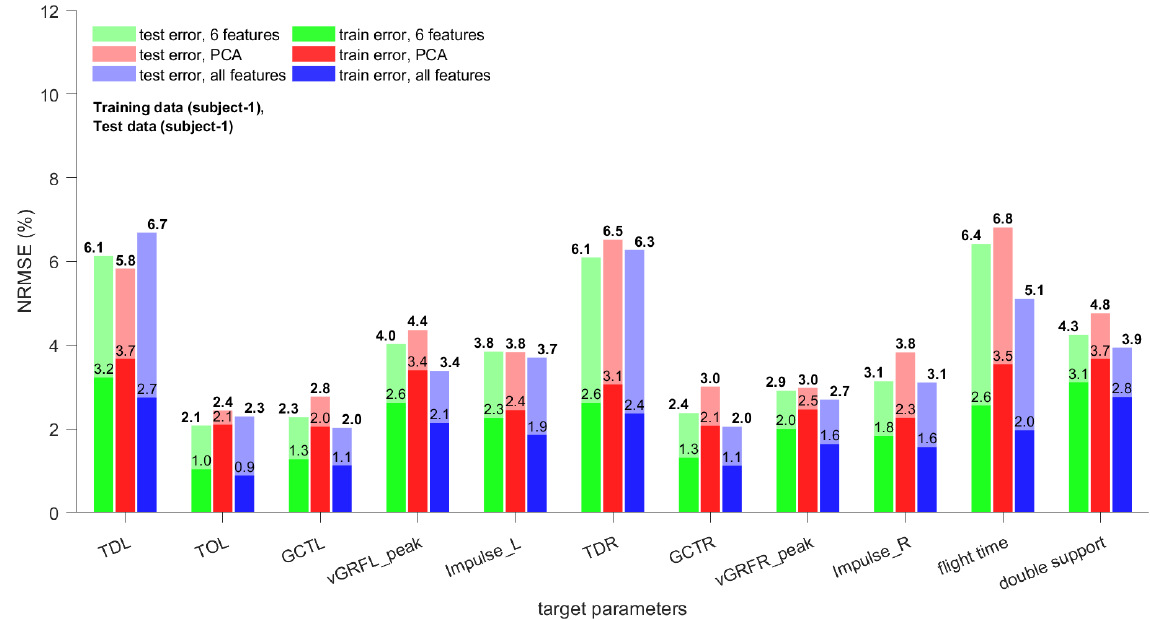
Figure 8. Normalized root mean square errors of three types of regression models (see Section 2.5 for details) for gait parameter estimates of training set and test set 1.